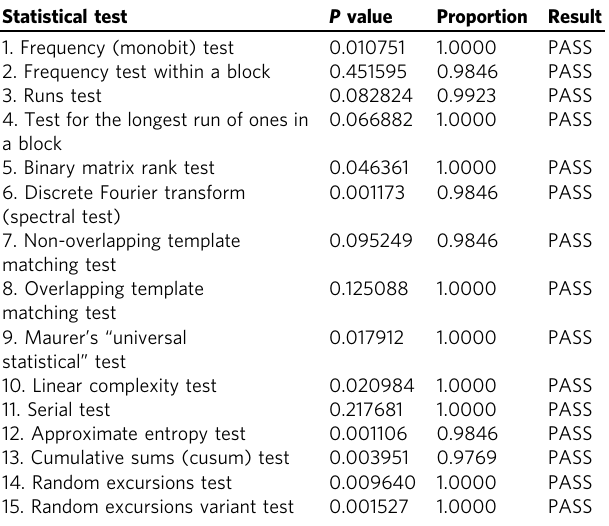
Table 1 The NIST test (800-22 test suite) results of the NbO x -based